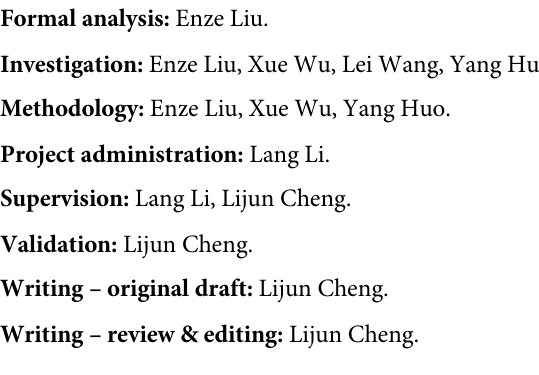
S3 Fig. Description: A demonstration of mapping tissue subnetworks to cell-line subnet- works. S1 Table. Description: Breakdown of computational steps and their time complexities of three methods. S2 Table. Description: Subnetwork SL members in TFRB tissue (stable 2.1) and cell lines (stable 2.2). S3 Table. Description: Pairwise genes (matching drugs) with synthetic lethylity prediction Impact Score (IS) score in TCGA triple nettive braest cancer(TNBC) by DSCN algorithm calculation. IS score is compared with database DrugComb and SynlethDB real SL score data. Here, we includes 1437 drugs which all targets could